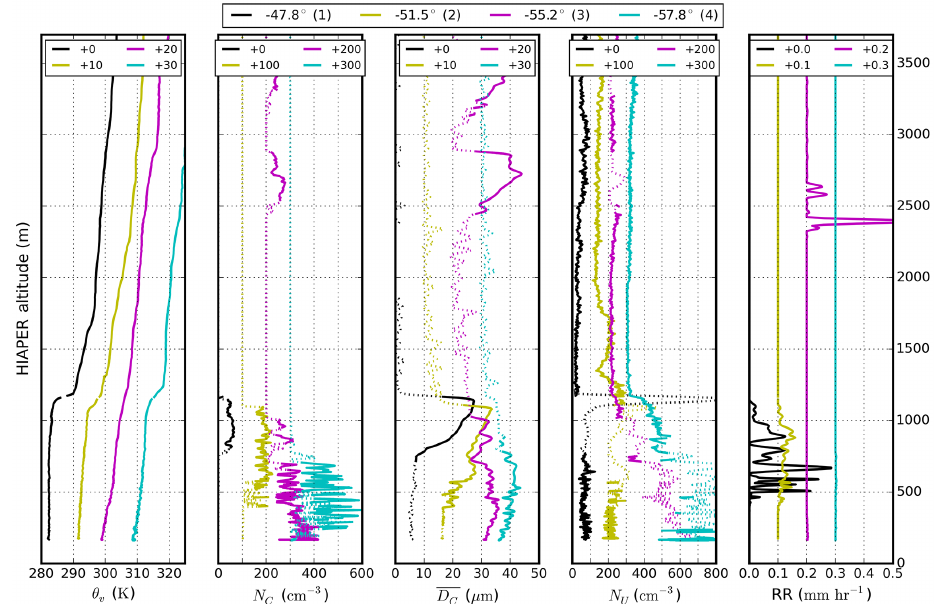
Figure 5. Profiles of microphysics variables within and above the boundary layer for RF06, with offsets for each profile indicated in the legend. From left: virtual potential temperature ( θ v , repeated for reference to other variables); CDP number concentration ( N C , dashed where ρ L < 0 . 05gm − 3 ); CDP mean diameter ( D C , dashed where ρ L < 0 . 05gm − 3 ); UHSAS number concentration ( N U ; dashed where ρ L > 0 . 01gm − 3 ); and 2DC-derived rain rate